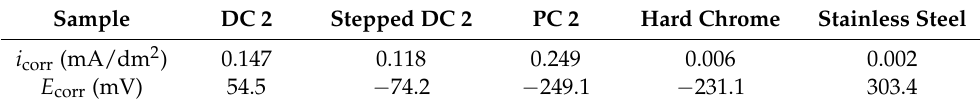
Table 5. Corrosion current density i corr and corrosion potential E corr values in 3.5% NaCl